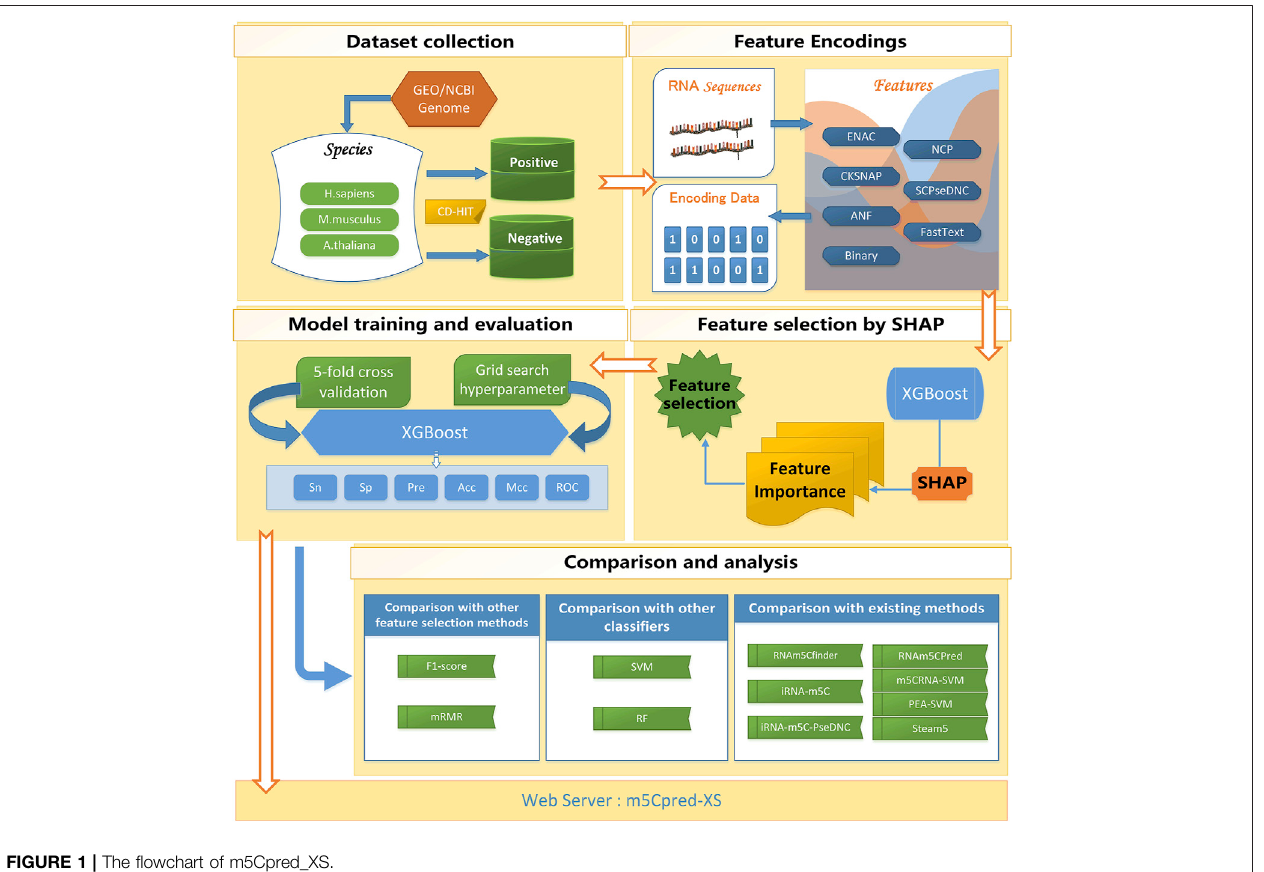
FIGURE 1 | The fl owchart of m5Cpred_XS.